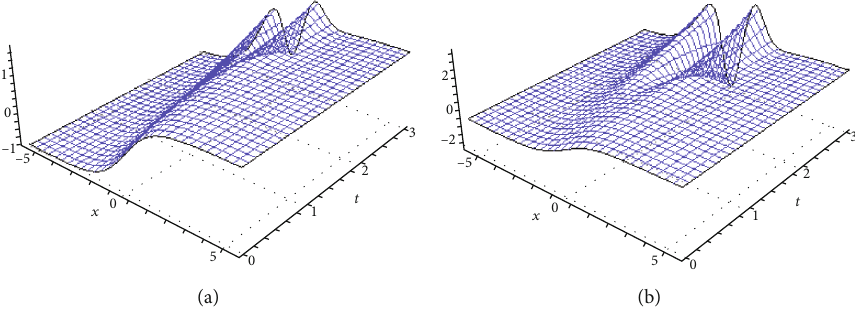
Figure 4: Surface plots of FCH4 model (40) and (41) with fi x α = 0 : 75 versus μ : (a) μ = 1 and (b) μ = 0 : 75 . Table 3: Comparison of numerical results for FCH4 model (21)-(22) with λ = 1 and α = 1